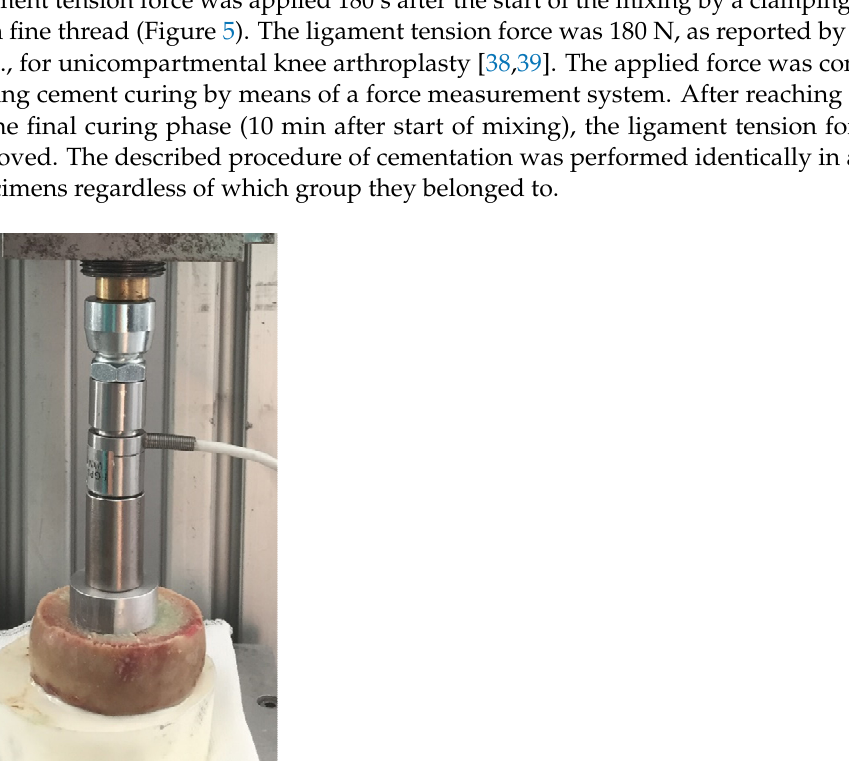
Figure 5. Femoral head ( bottom ) with round test implant cemented to the bone surface and the force measurement system ( top ).